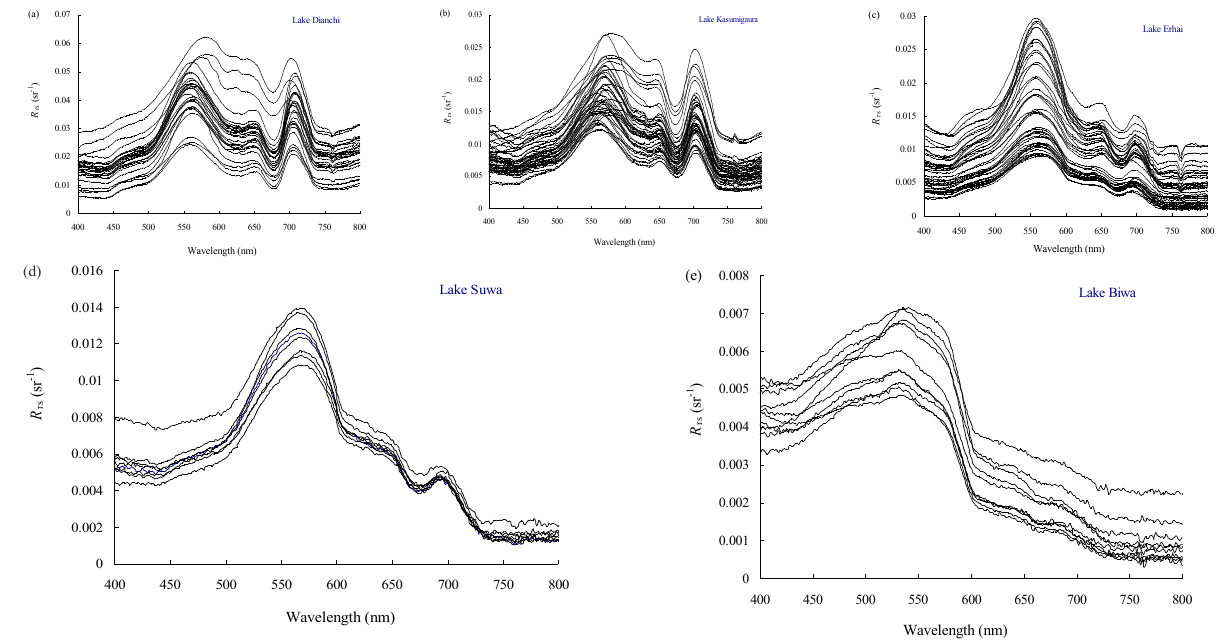
Figure 2. Remote-sensing reflectance collected from Lakes Biwa, Erhai, Suwa, Kasumigaura and Dianchi.